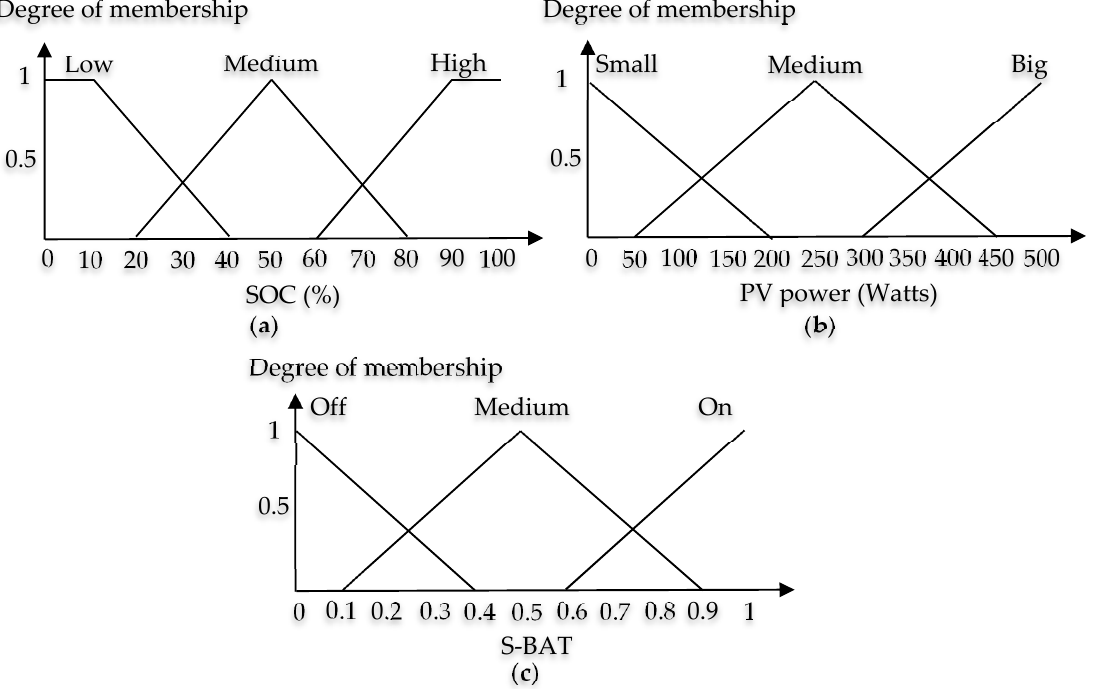
Figure 3. Membership functions of FLC-BAT: ( a ) membership function of the SOC variable; ( b ) membership function of the PV power variable; ( c ) membership function of the S-BAT variable.